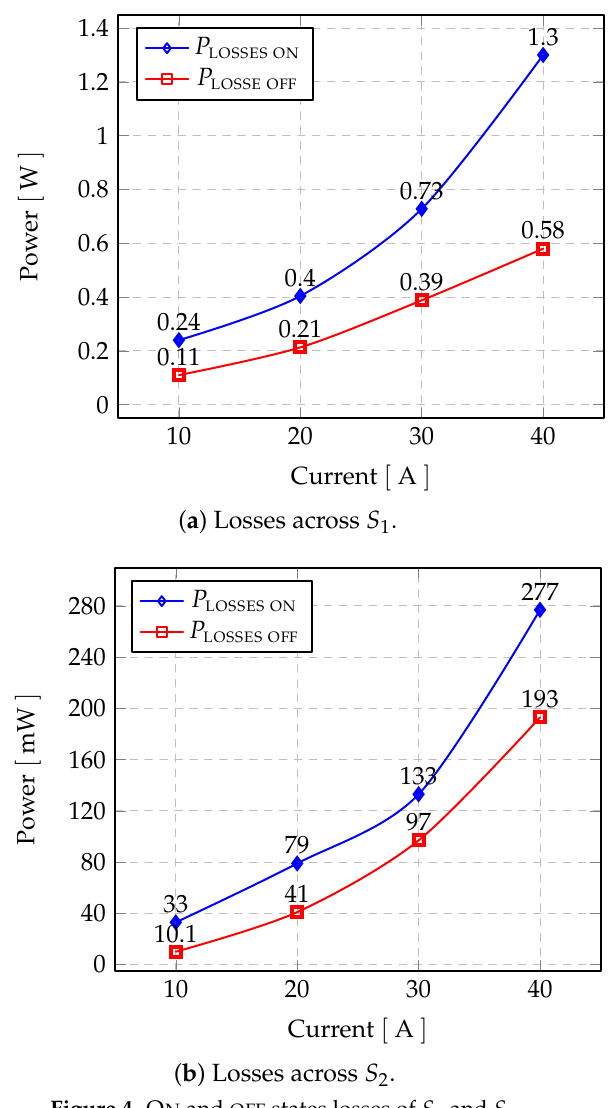
Figure 4. O N and OFF states losses of S 1 and S 2